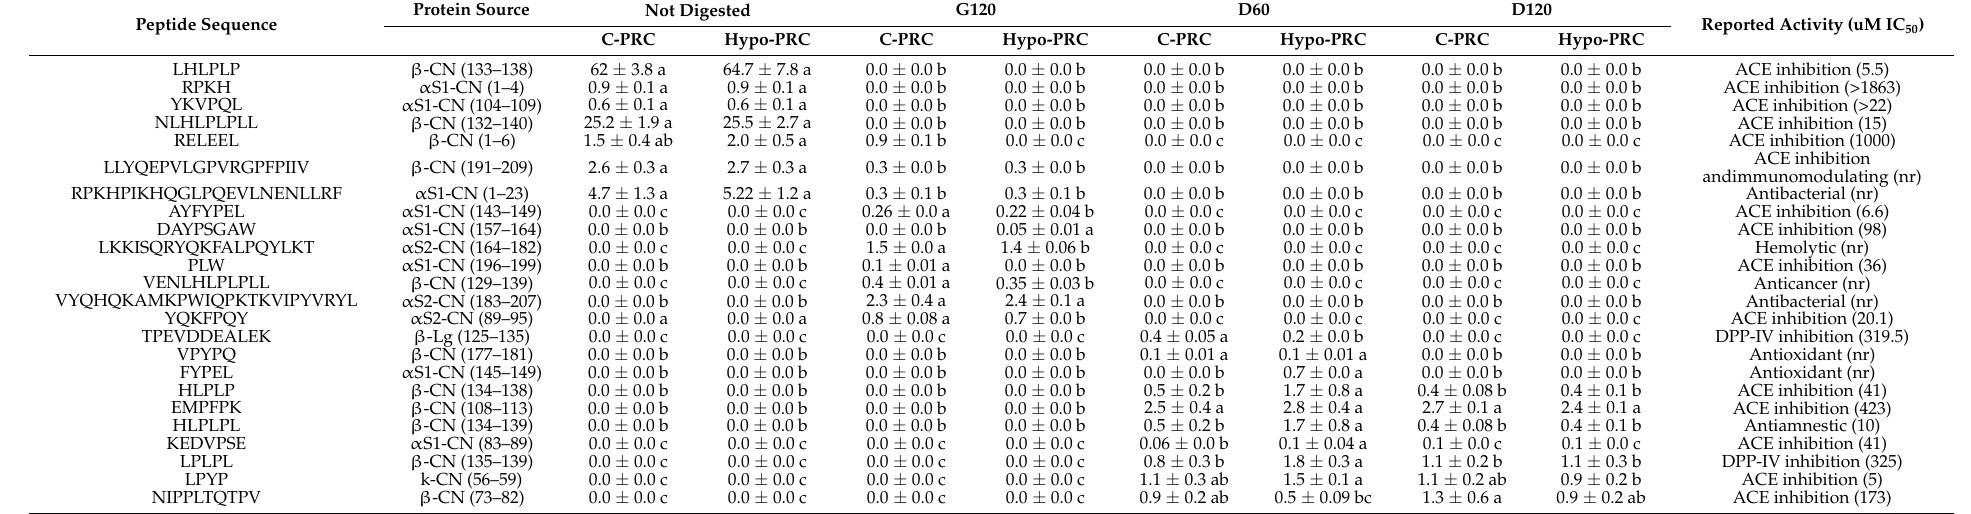
Table 3. Relative bioactive peptide abundance in conventional Parmigiano Reggiano cheese (C-PRC) and hyposodic Parmigiano Reggiano cheese (Hypo-PRC) at different digestion